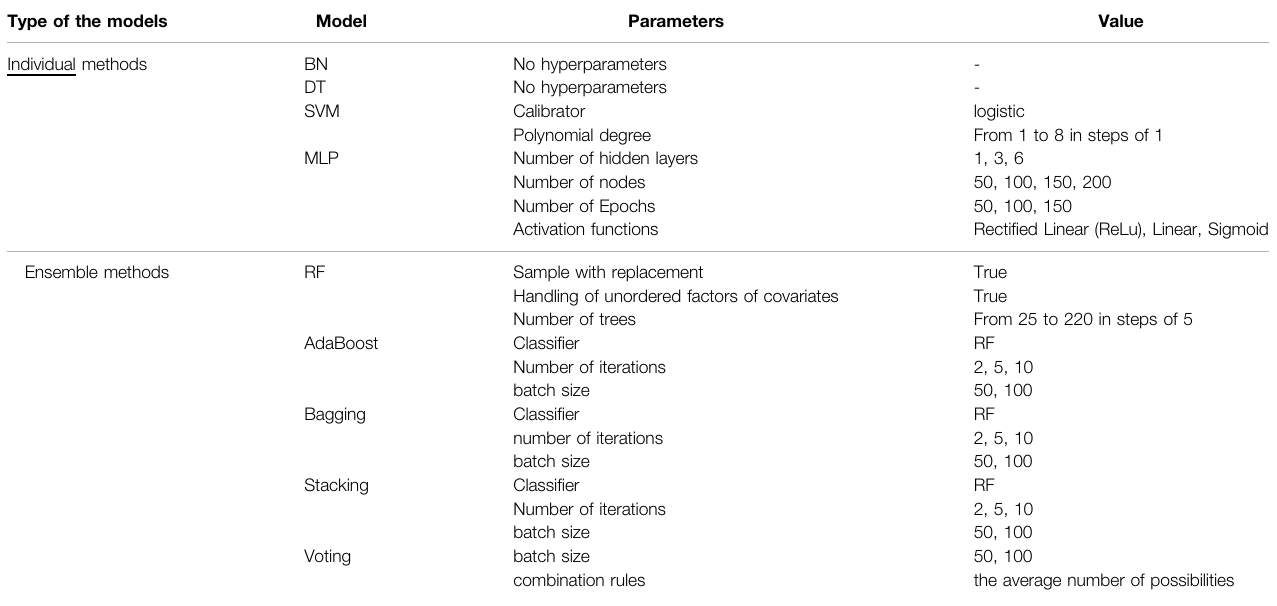
TABLE 4 | Hyperparameters across different models along with their